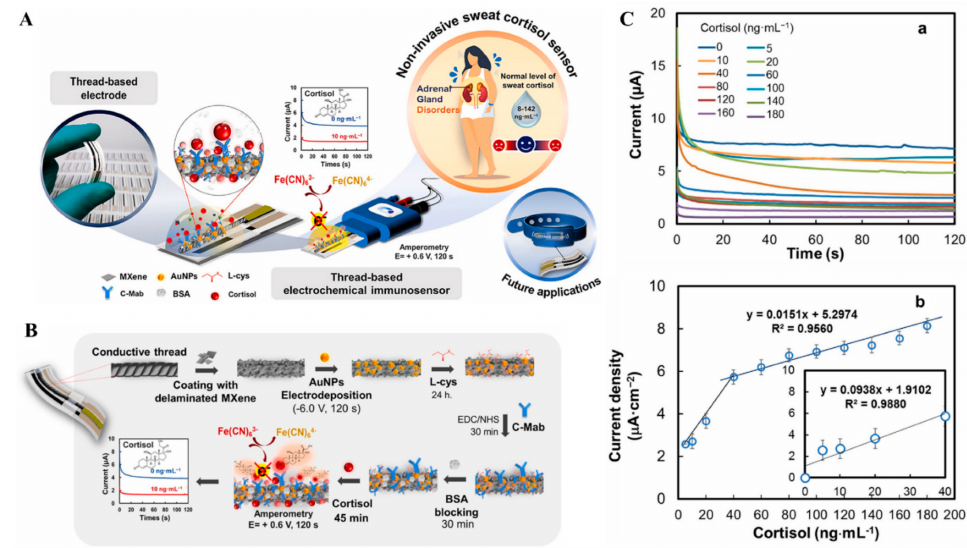
Figure 9. Schematic illustration of ( A ) MXene–based non-invasive sweat–cortisol sensor and ( B ) Thread–based electrochemical immunosensor fabrication for cortisol detection. ( C ) Ampero- metric responses for cortisol in the concentration range of 5–180 ng/mL at the applied potential +0.6 V (vs. Ag/AgCl) for 120 s ( a ). Calibration plot of the cortisol sensor ( b ). Reproduced with permission from Ref. [170]. Copyright © 2022 Elsevier.